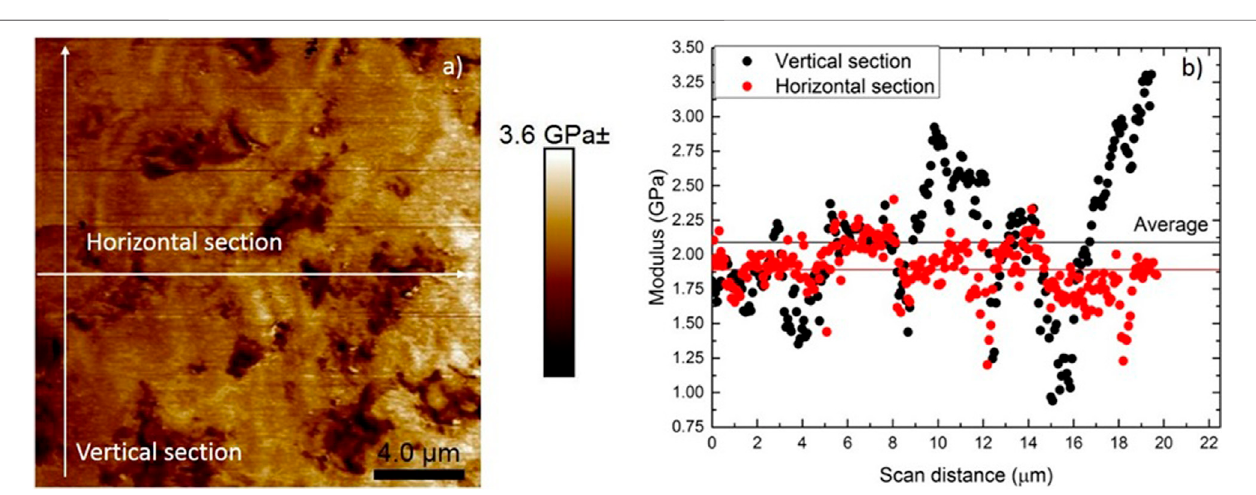
FIGURE 11 | (A) Modulus contour map and (B) modulus distribution across a horizontal and vertical